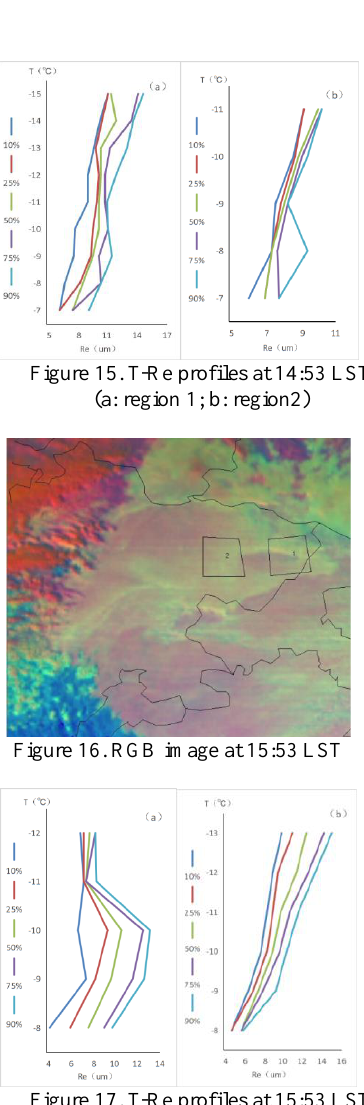
Figure 17. T-Re profiles at 15:53 LST (a: region 1; b: region 2)